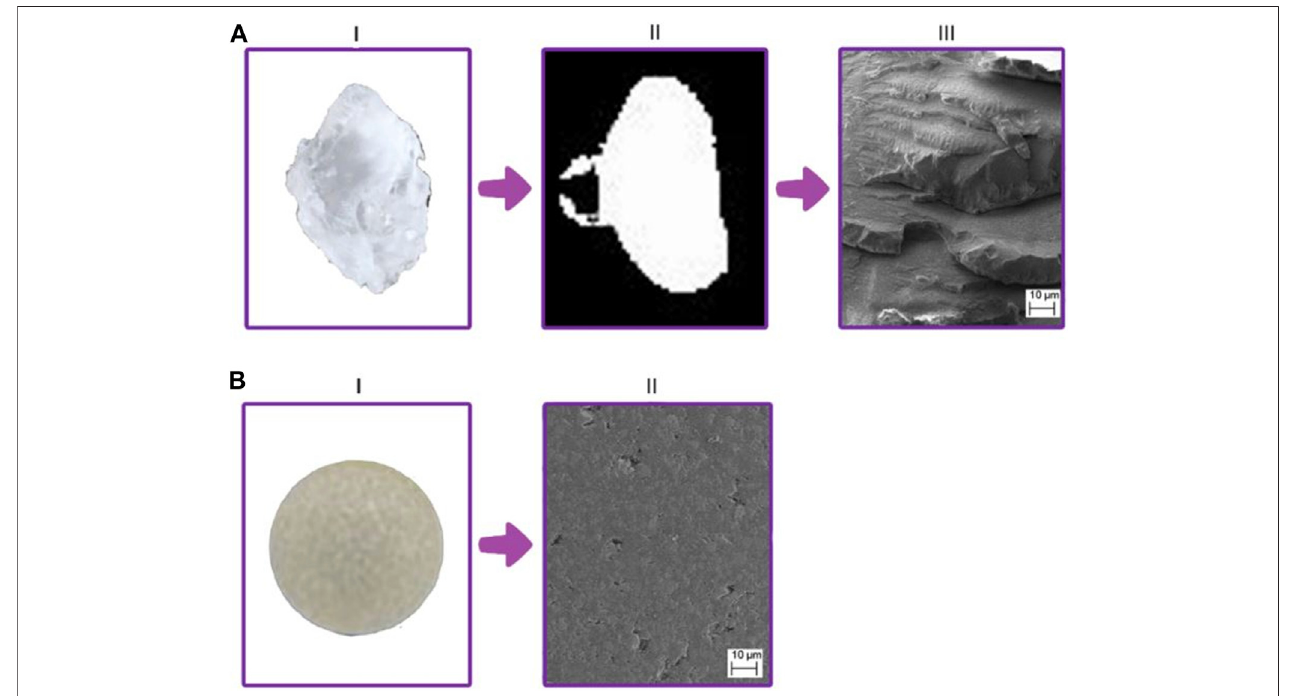
FIGURE11| In fl uenceofpolymersurfaceroughnessontheTSVforPSpolymer. (A) I-IrregularPSMP,theimage wastakenbymicroscope,II- theparticlesettling in water with an air bubble attached on it. This image was obtained from the PIV system, III- Particle roughness, image was taken by a Scanning Electron Microscope (SEM). (B) I- Regular PS MP (spherical shape - image by microscope, II- SEM image of the surface of the